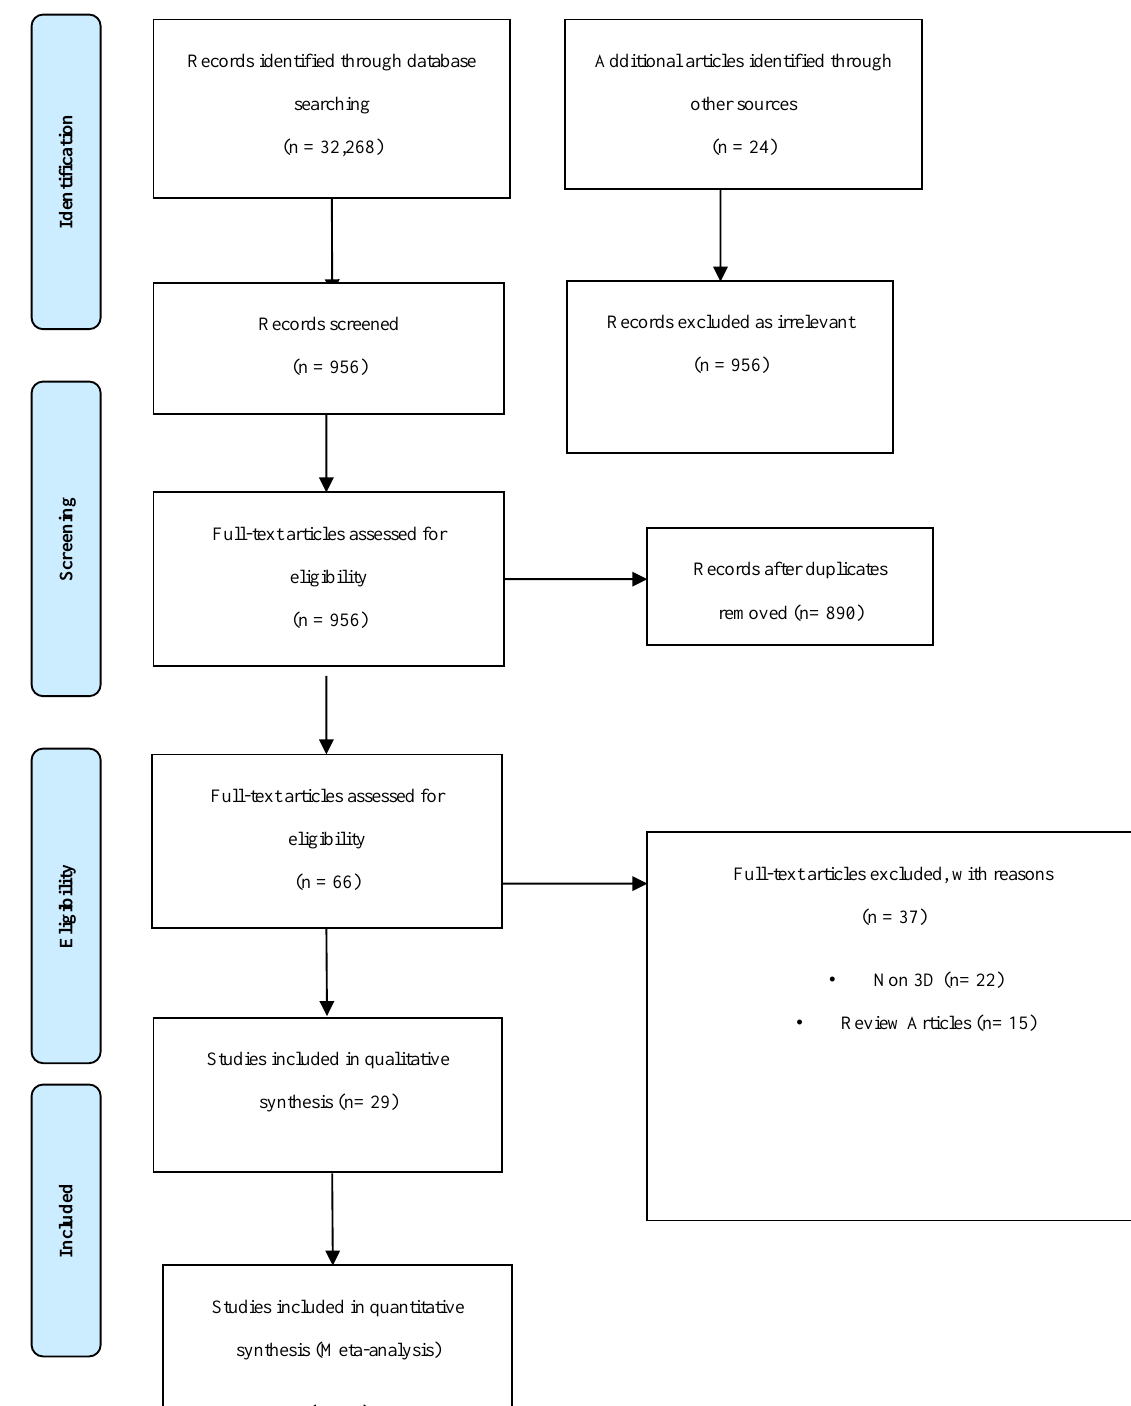
Figure 1. PRISMA flow diagram.